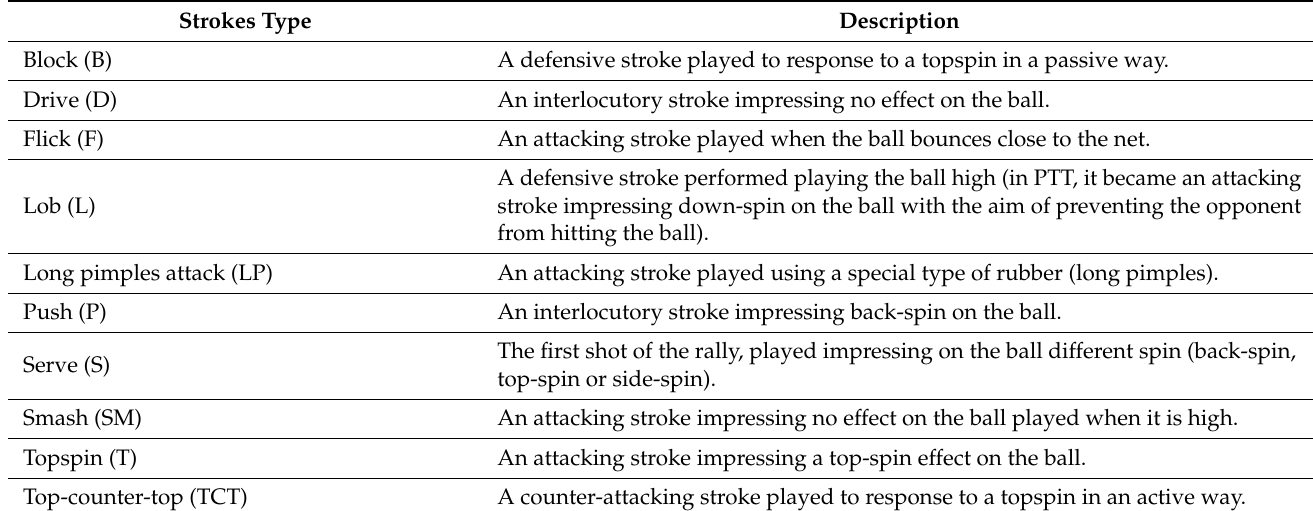
Table 1. Description of strokes-type categories.